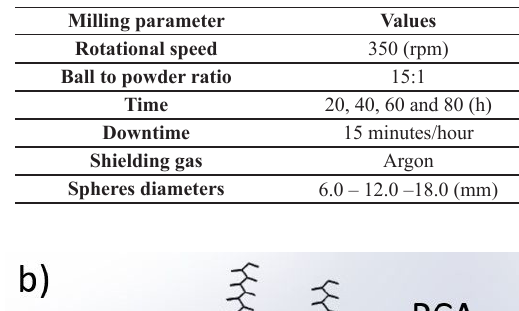
Table 3. Experimental parameters in the MA process.